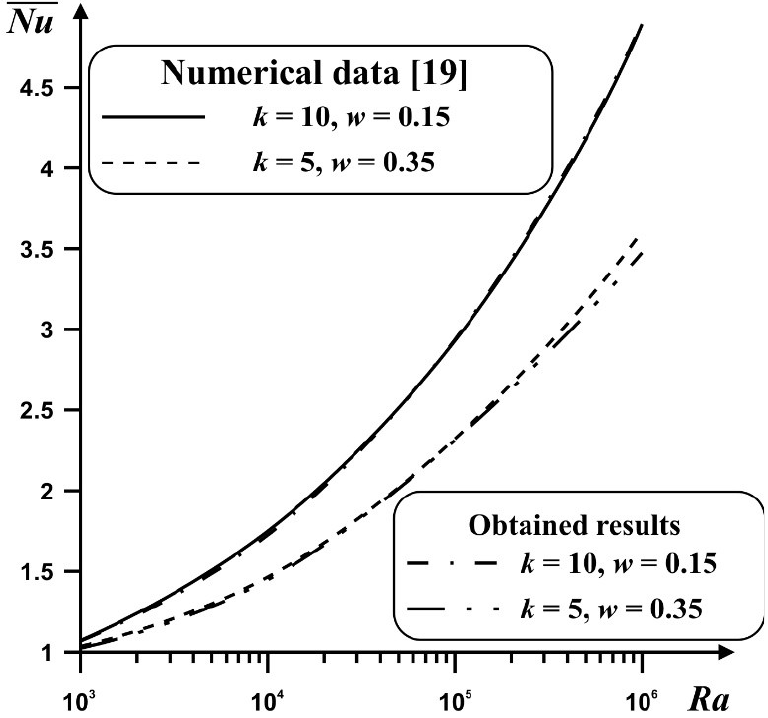
Figure 3. Dependences of the mean Nusselt number on Ra , heat conductivity ratio, and solid wall thickness in comparison with the numerical data [19].